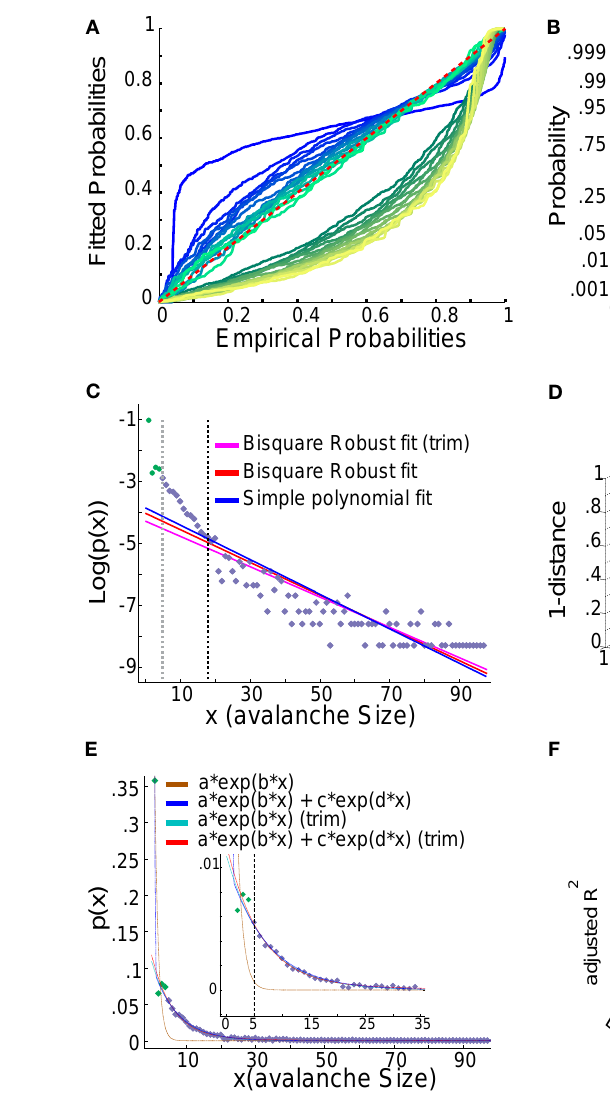
FIGURE 13 | (A,B) Fits comparison and lower boundary. (C–F) Alternative fits for avalanche size distributions. (A) Probability-Probability plot (ECDF vs. provisional CDF) for a sample bin size (cat i spike avalanche). Green colors are p-p plot for ECDF vs. exponential, and blue colors are for p-p plot for ECDF vs. power-law. In each color family, as the lower boundary is increased (from 1 to X min ), the color saturation fades; i.e., darkest color shows lower boundary of 1 and the lightest shows lower boundary of X min (where X min is based on the Clauset method for fitting power-law to empirical data). (B) Integral of p-p distance to the 1:1 diagonal (perfect match of the parametric CDF to ECDF). The colors (blue to red) are related to bin sizes (from smallest to biggest). Cross signs represents exponential distance and circles represents power-law distance to the ECDF. (C) Simple exponential fitting of spike avalanche data. The data points (purple and green) are plotted in a log-linear representation, together with a simple polynomial fit (blue), a robust fit calculated on the full length data (red) and a robust fit on the reduced data (magenta).The two vertical lines indicate the lower bound of the region of linearity, i.e., “ X min ,” calculated based on the simple polynomial fit (black) and the bi-square method (gray). (D) Comparison of the goodness of fit of different exponential